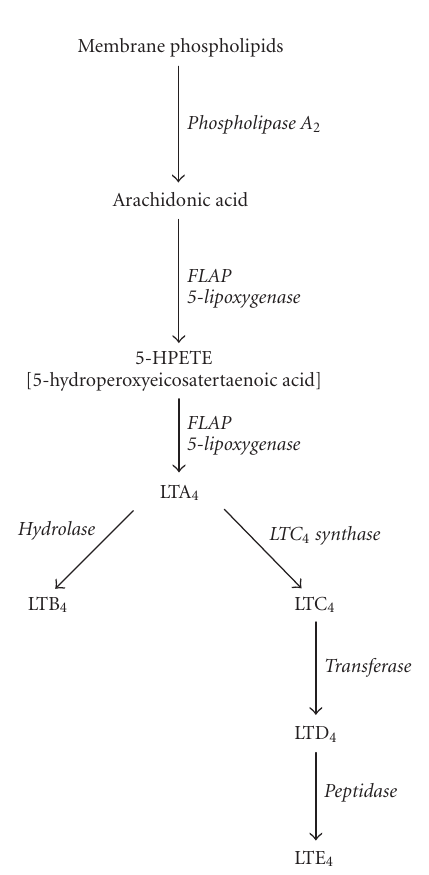
Figure 1. Pathways of LT biosynthesis. Arachidonic acid is lib- erated from membrane phospholipids by the action of cytoso- lic phospholipase A 2 (cPLA 2 ) and presented to 5-LO enzyme by FLAP. 5-LO enzyme converts arachidonic acid to an un- stable intermediate termed 5-hydroperoxyeicosatetraenoic acid (5-HPETE). Subsequently, 5-HPETE is dehydrated to yield the epoxide LTA 4 , a pivotal intermediate in the biosynthesis of in- flammatory and anaphylactic mediators. Enzymatic hydrolysis of LTA 4 by LTA 4 hydrolase results in the formation of LTB 4 . Al- ternatively, LTC 4 synthase catalyzes the conjunction of LTA 4 with glutathione to form LTC 4 , which may be converted to LTD 4 and LTE 4 by the actions of the transferase and peptidase enzymes,